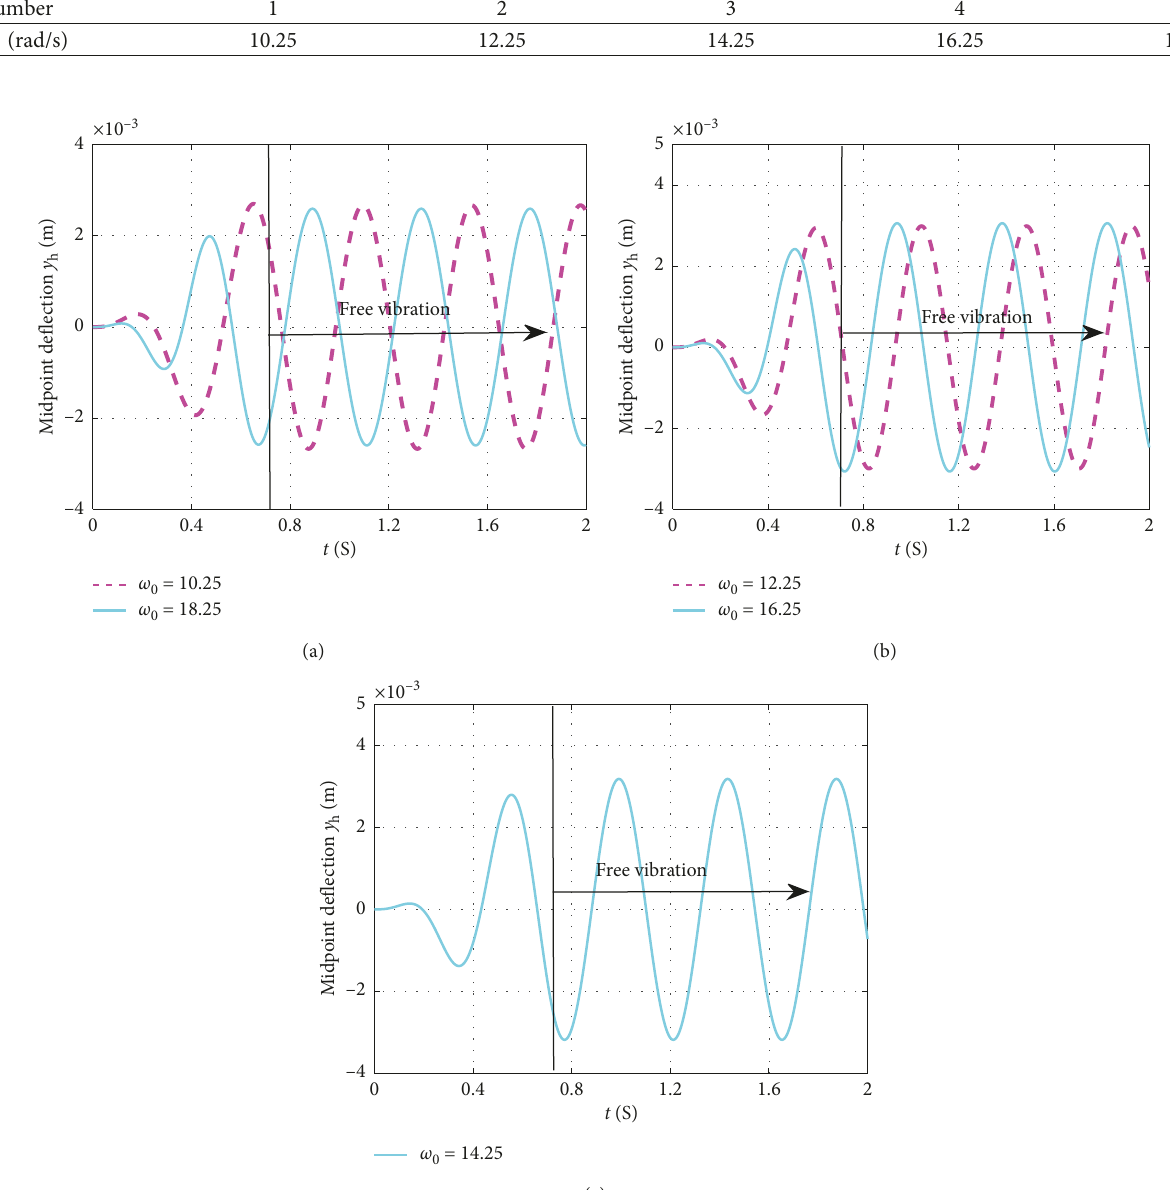
Table 4: Selected five frequencies ω